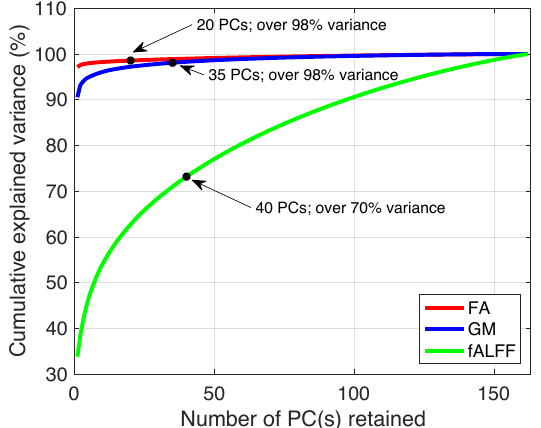
Figure 2. Cumulative explained variance accounting for different PCs from the FA, GM, and fALFF datasets. For each dataset, the black point on the curve indicates the variance explained by the number of PCs we